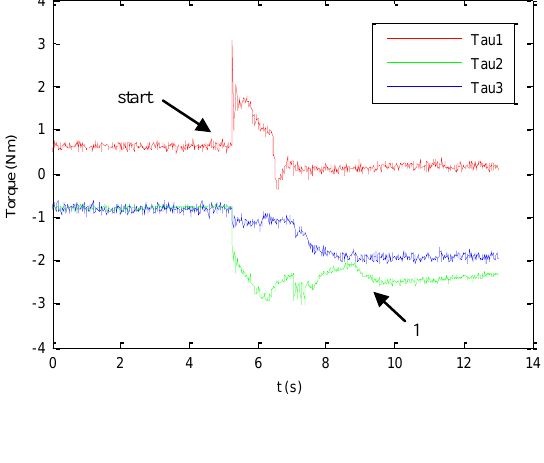
Figure 6. Torques employed to guide the mini-robot during the first